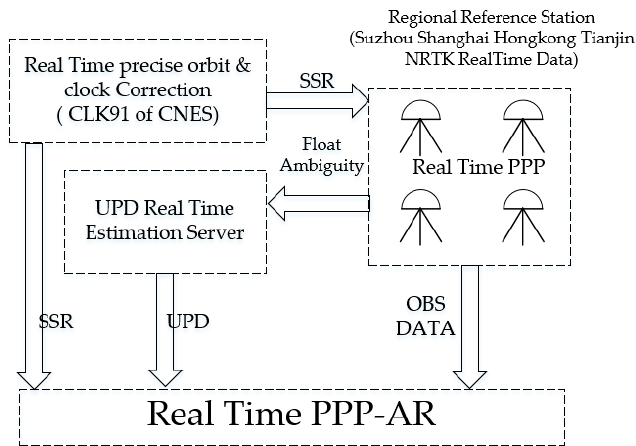
Figure 1. Regional Station Distribution Diagram.